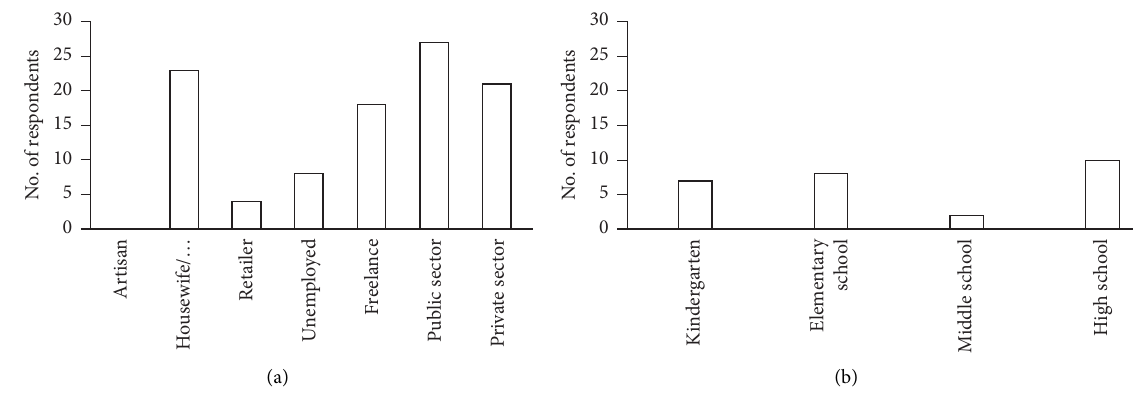
Figure 3: (a) Job status; (b) school status.